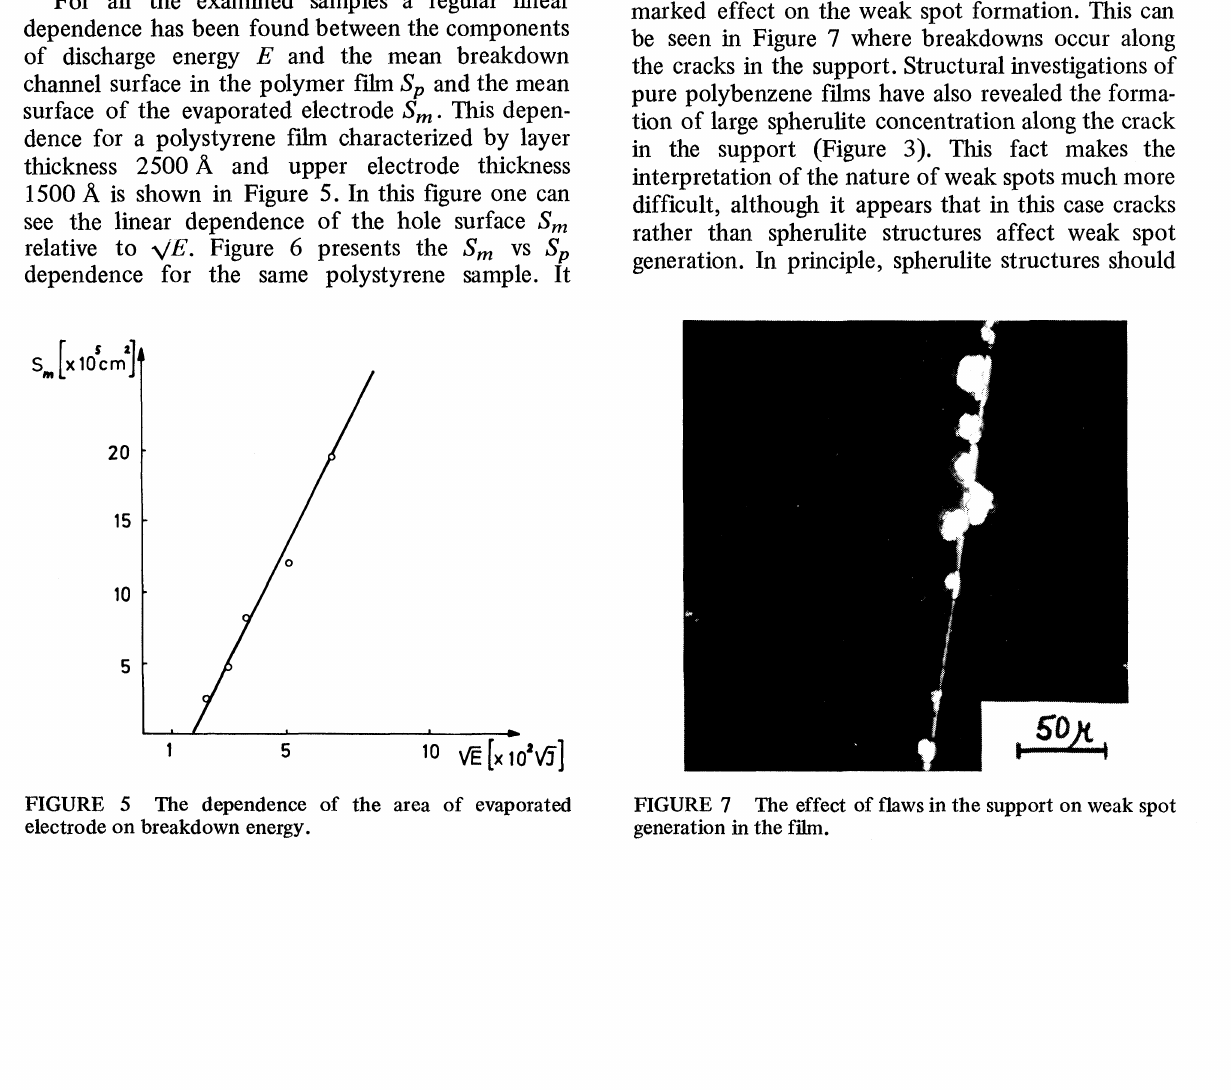
FIGURE 5 The dependence of the area of evaporated electrode on breakdown energy.